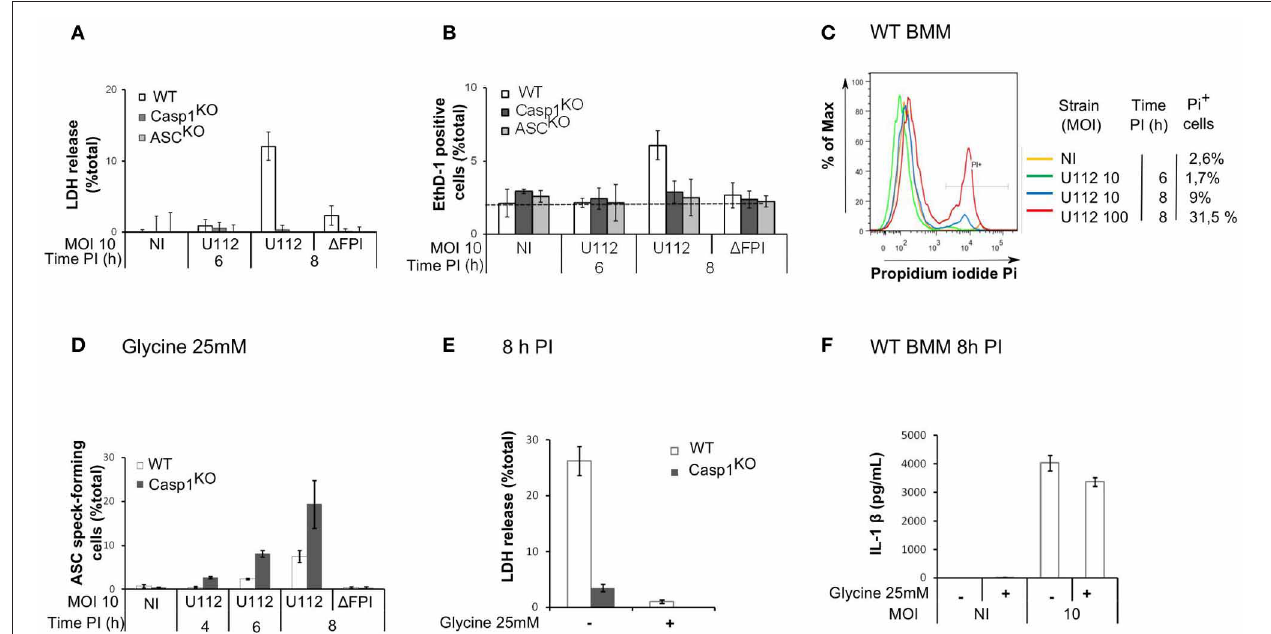
FIGURE 2 | The ASC/caspase-1-mediatednegative regulation of AIM2 complex formation is not due to an early death of WT macrophages. (A–C) Kinetics of cell death in BMM from the indicated genotypes infected with F. novicida or the (cid:2) FPI mutant at the indicated MOI for the indicated time. Cell death was determined by LDH assay (A) , microscopy following EthD-1 addition (B) and flow cytometry using propidium iodide (C) .